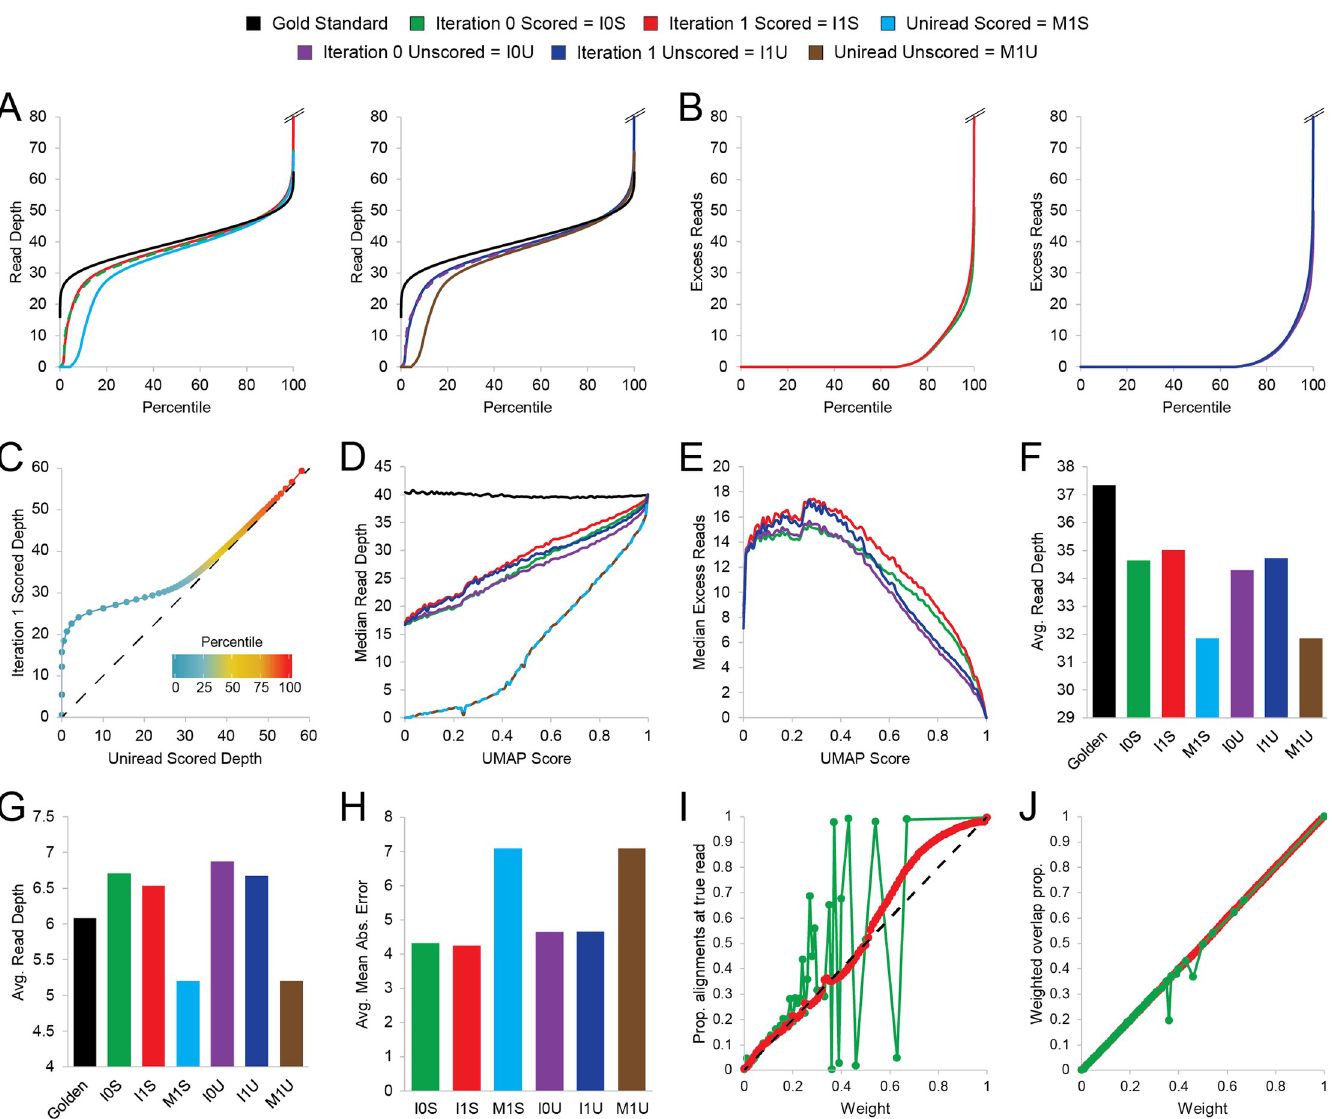
Fig 3. SmartMap and uniread analyses of the validation dataset. Iteration 0 and iteration 1 refer to SmartMap analysis with 0 and 1 iterations of reweighting, respectively. Scored and unscored refer to whether alignment score was considered in analysis, per Methods. Dashed lines are presented for readability of overlapping curves rather than discontinuities in data throughout this figure. (A) Quantile plot of read depth at the true origin loci, with Gold Standard dataset and analysis conducted in (left) scored mode or (right) unscored mode. (B) Quantile plot of excess read depth in SmartMap datasets relative to corresponding uniread dataset at true origin loci in (left) scored mode and (right) unscored mode. (C) QQ plot of read depth at true origin loci in the SmartMap (1 iteration) scored dataset vs. uniread scored dataset. Color scale represents percentile of each point, from 1 st to 99 th percentiles. (D-E) Median (D) read depth or (E) excess read depth vs. mappability score (UMAP50) [25] of the true origin loci. (F-G) Average read depth (F) at true origin loci and (G) outside true origin loci. (H) Mean absolute error of read depth at true origin loci for each dataset, with Gold Standard as the reference point. (I) Mean proportion of alignments intersecting with the true read of origin for each weight after SmartMap with no reweighting (green) and one iteration of reweighting (red) in scored mode. Dashed line represents line with slope of unity. (J) Mean weighted overlap proportion score between alignments intersecting the true read of origin and the true read locus for each weight after SmartMap with no reweighting (green) and one iteration of reweighting (red) in scored mode. Weighted overlap proportion score is meant to represent the proportion of a read’s weight that maps to the correct location due to a particular alignment and is computed as a weighted geometric mean of the proportion of the alignment covered by the true read and the proportion of the true read covered by the